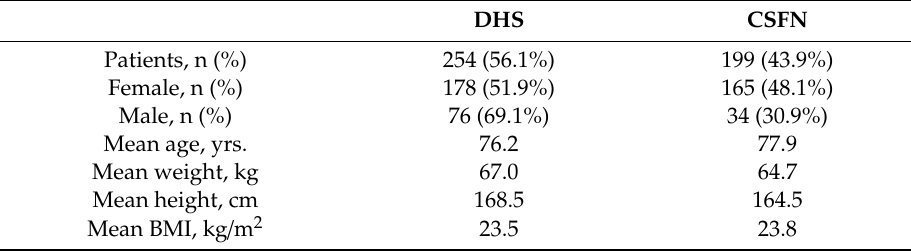
Table 1. Baseline data for all patients included in the